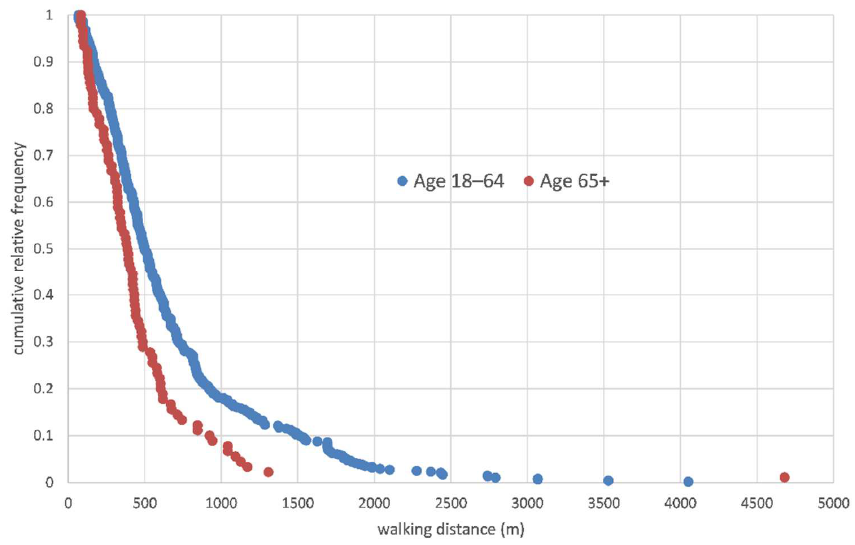
Figure 1. Cumulative relative frequency of walking distances in Ostrava and Olomouc, 2014.